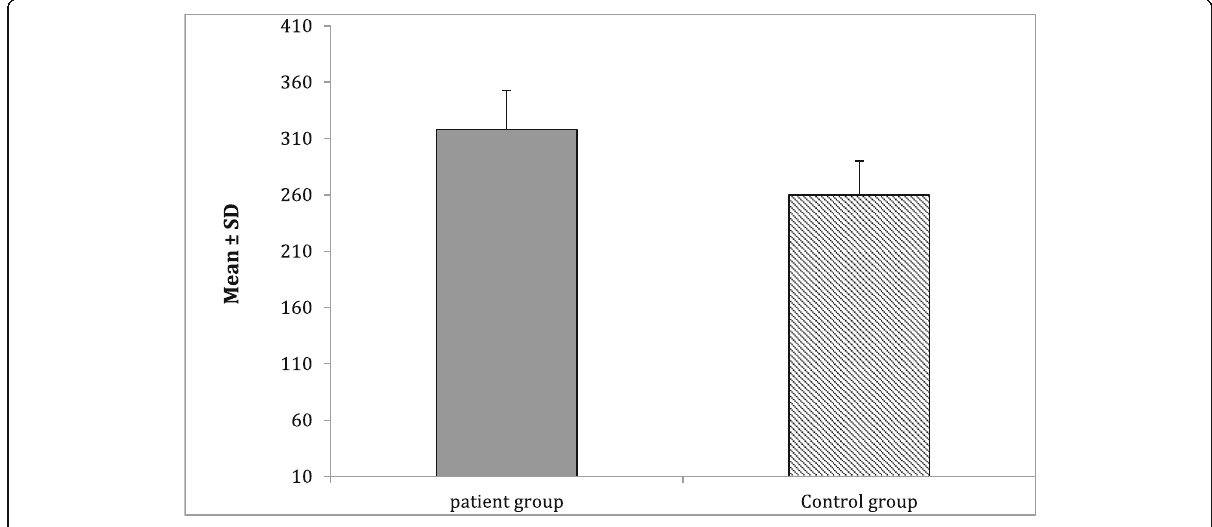
Fig. 1 Serum level of (IL-2) in both studied